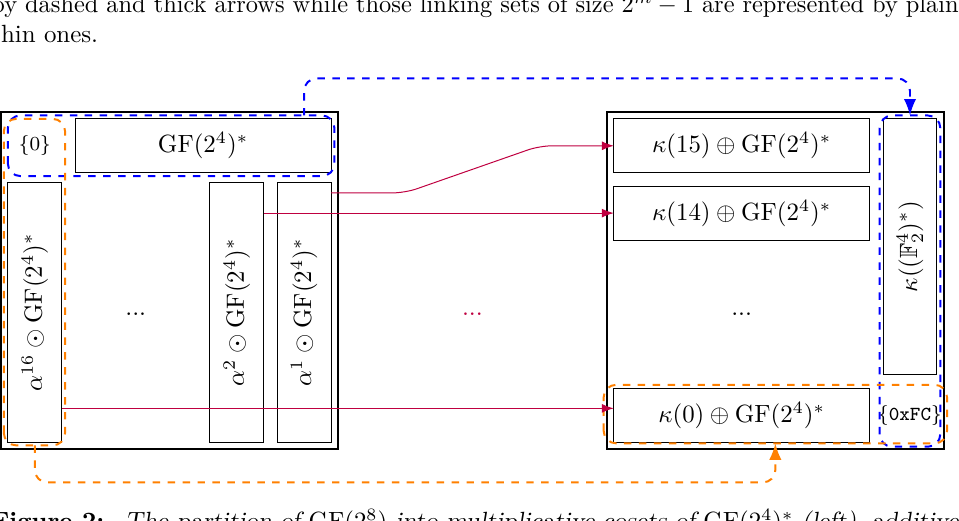
Figure 2: The partition of GF(2 8 ) into multiplicative cosets of GF(2 4 ) * (left), additive cosets of GF(2 4 ) * (right), and the action of 𝜋 on them